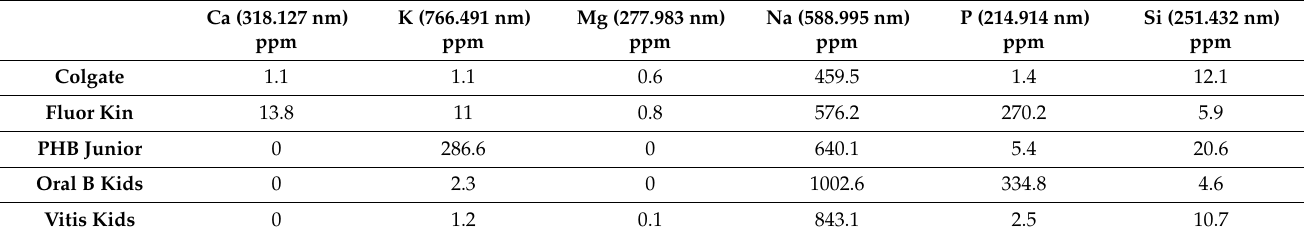
Table 2. ICP-MS results.